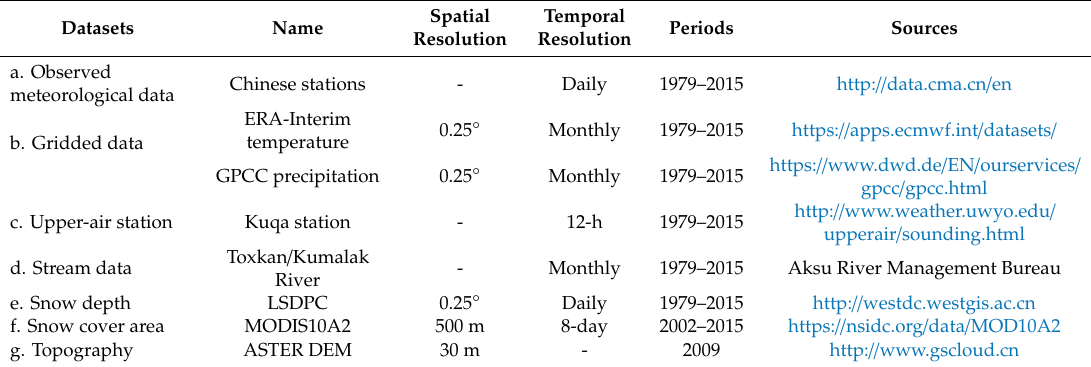
Table 2. Summary of the datasets used in this